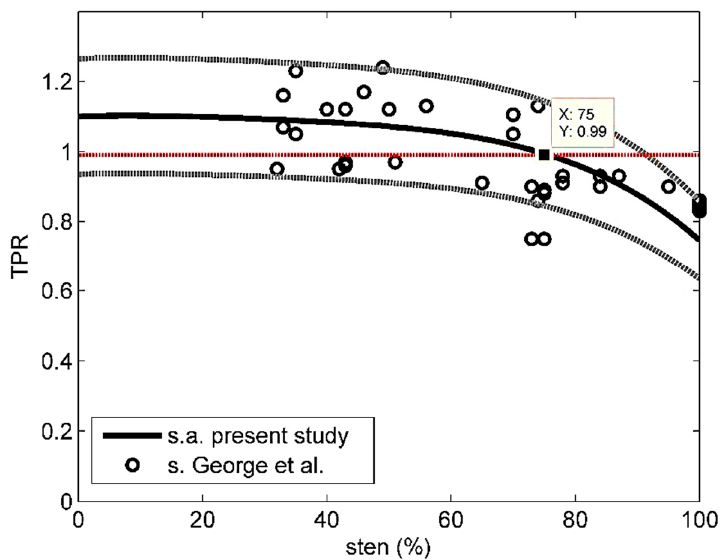
Figure 4. Comparison between stress TPR estimated by George et al. [25] and average stress TPR estimated by the present study; ‘s’ stands for stress and ‘s.a.’ for stress-average. Gray dotted lines indicate 85% confidence intervals.